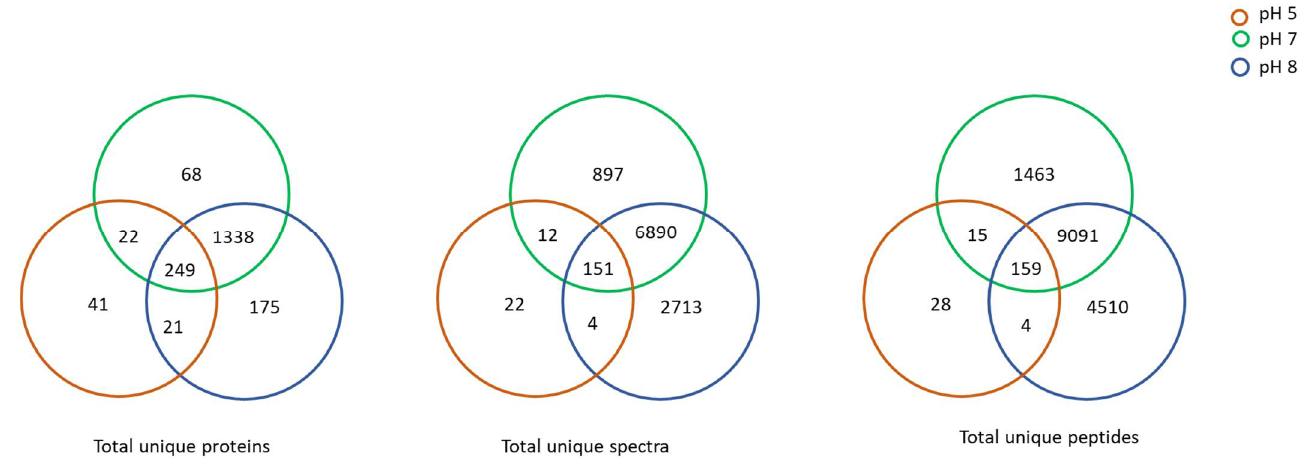
Figure 4. Venn diagrams summarizing the total unique proteins, spectra and peptides obtained from B. subtilis (EB2004S) CFS produced at pH 5, pH 7 and pH 8.